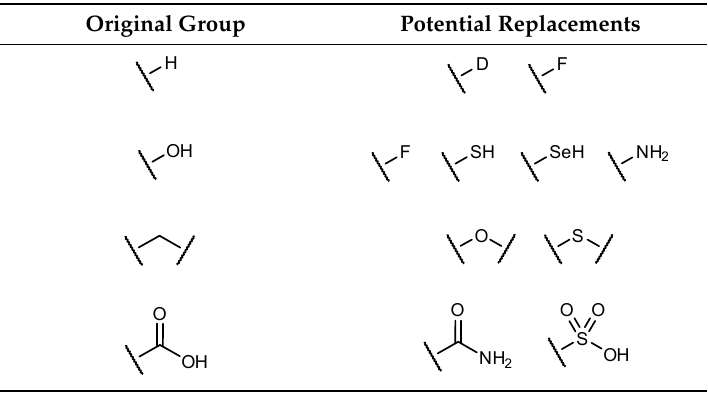
Table 2. Common bioisosteres of different functional groups.